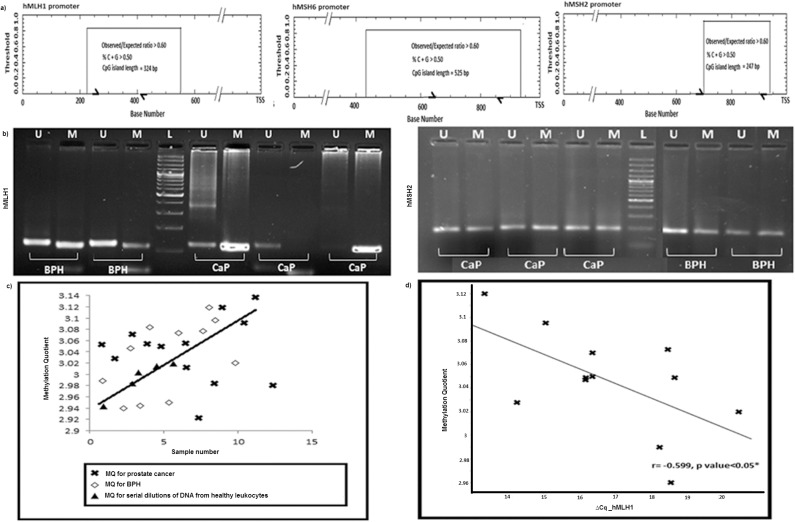
Promoter hypermethylation of MMR genes.(a) Diagram showing the in silico mapping of putative CpG islands in the promoter region of hMLH1, hMSH6 and hMSH2 genes with position of forward and reverse primers demarcated as half arrows which were used in methylation assays. TSS indicates the transcriptional start site.(b) Gel photograph illustrating the methylation status of hMLH1 and hMSH2 promoter region CpG islands in prostate cancer and BPH tissues as determined by methylation-specific PCR in the left and right panels respectively. Primer sets for amplification were designated as unmethylated (U) and methylated (M).The presence of PCR product in lanes marked U indicates unmethylated hMLH1 and hMSH2; product in lanes marked M indicates hypermethylated hMLH1 and hMSH2. L indicates 100 bp plus ladder. (c) Distribution of methylation quotients [MQ = (logMLH1/ACTB) X1000] obtained from analyzing prostate cancer and BPH tissue DNAs using qMSP. The calibration curve was generated to determine quantitative accuracy of qMSP with five different dilutions of in vitro fully methylated DNA from normal healthy human lymphocytes.(d) Plot showing correlation between transcript levels of hMLH1 (∆Cq) in prostate cancer tissue samples with methylation quotients corresponding hMLH1 promoter. Pearson’s correlation coefficient (r) and P values are indicated for each test. * indicates P <0.05.